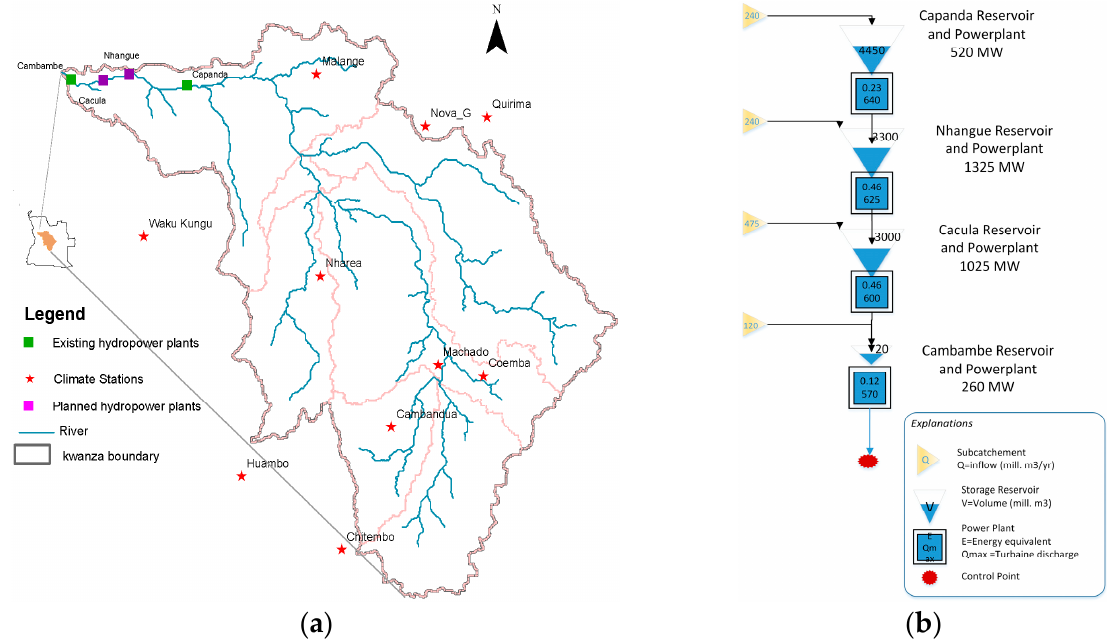
Figure 4. ( a ) Location of existing and planned hydropower stations on Kwanza River. ( b ) Is nMAG model setup for Kwanza hydropower system.